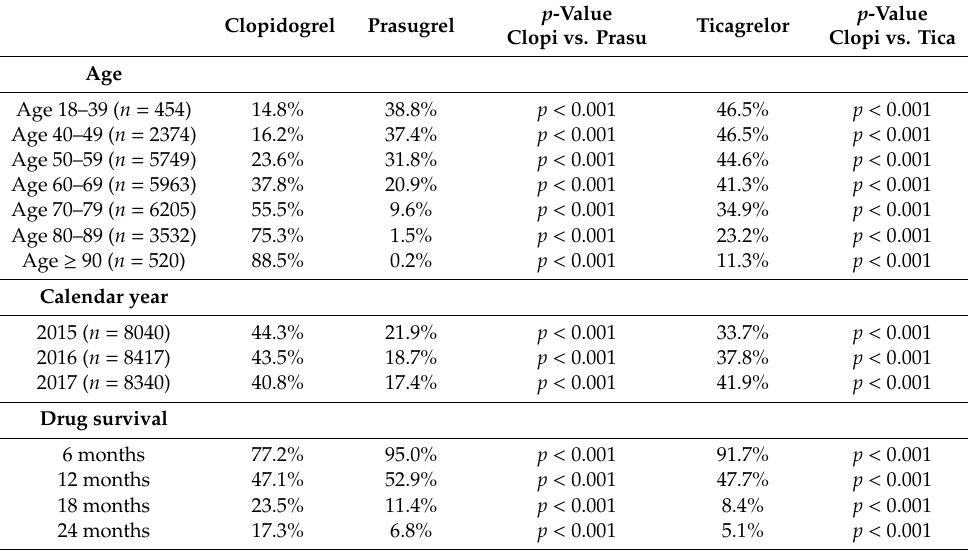
Table 2. Prescription rate (%) of P2Y12 inhibitors according to age, calendar year, and drug survival over 24